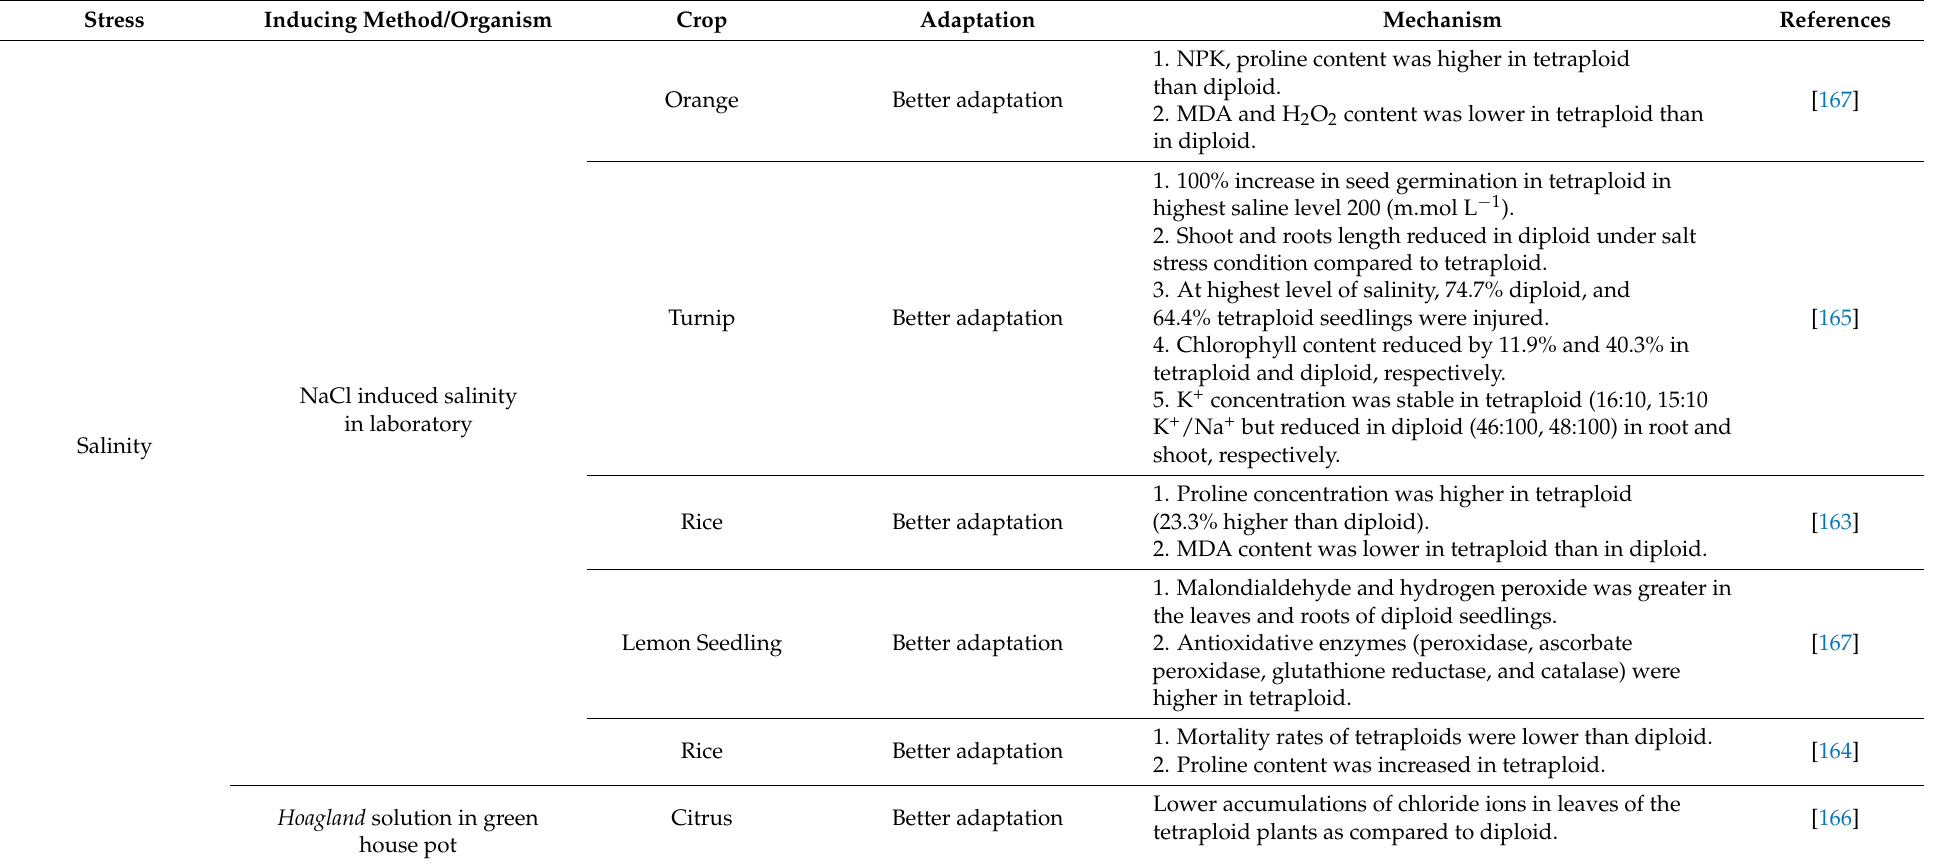
Table 3. Effect of polyploidy on abiotic stress